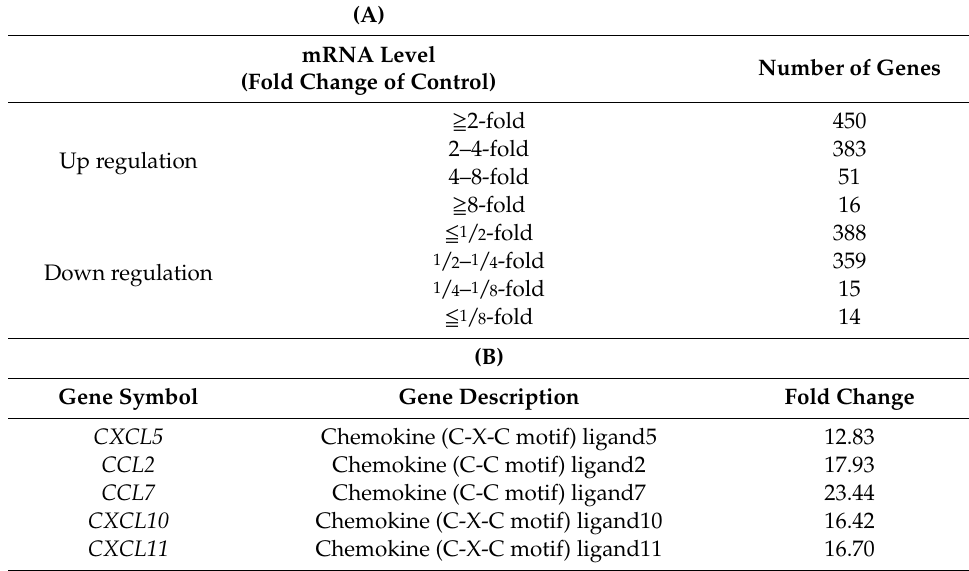
Table 2. ( A ) Number of genes by mRNA expression level in the NiO-high dose group at one month. ( B ) Description of the genes that are related to ‘inflammatory response’ among the 16 genes upregulated (cid:61)